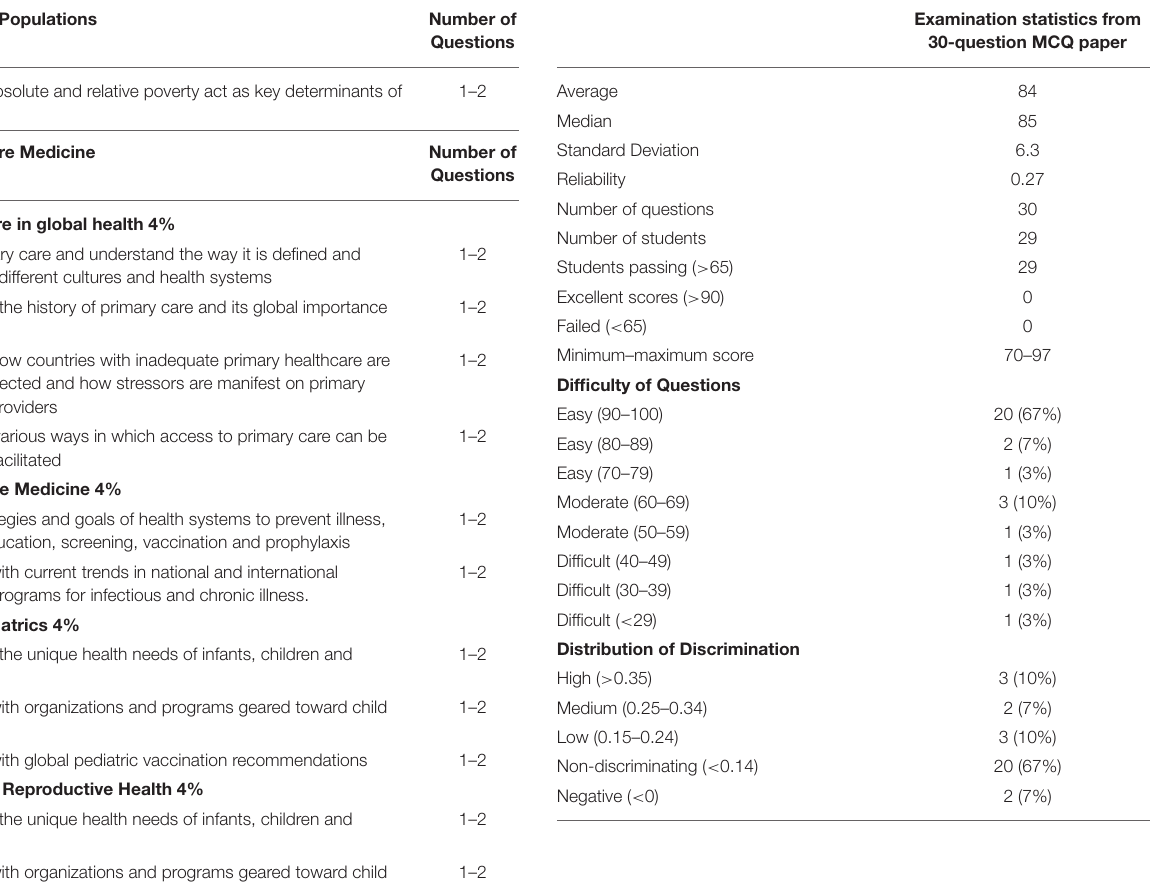
TABLE 5 | Statistics of administered global health